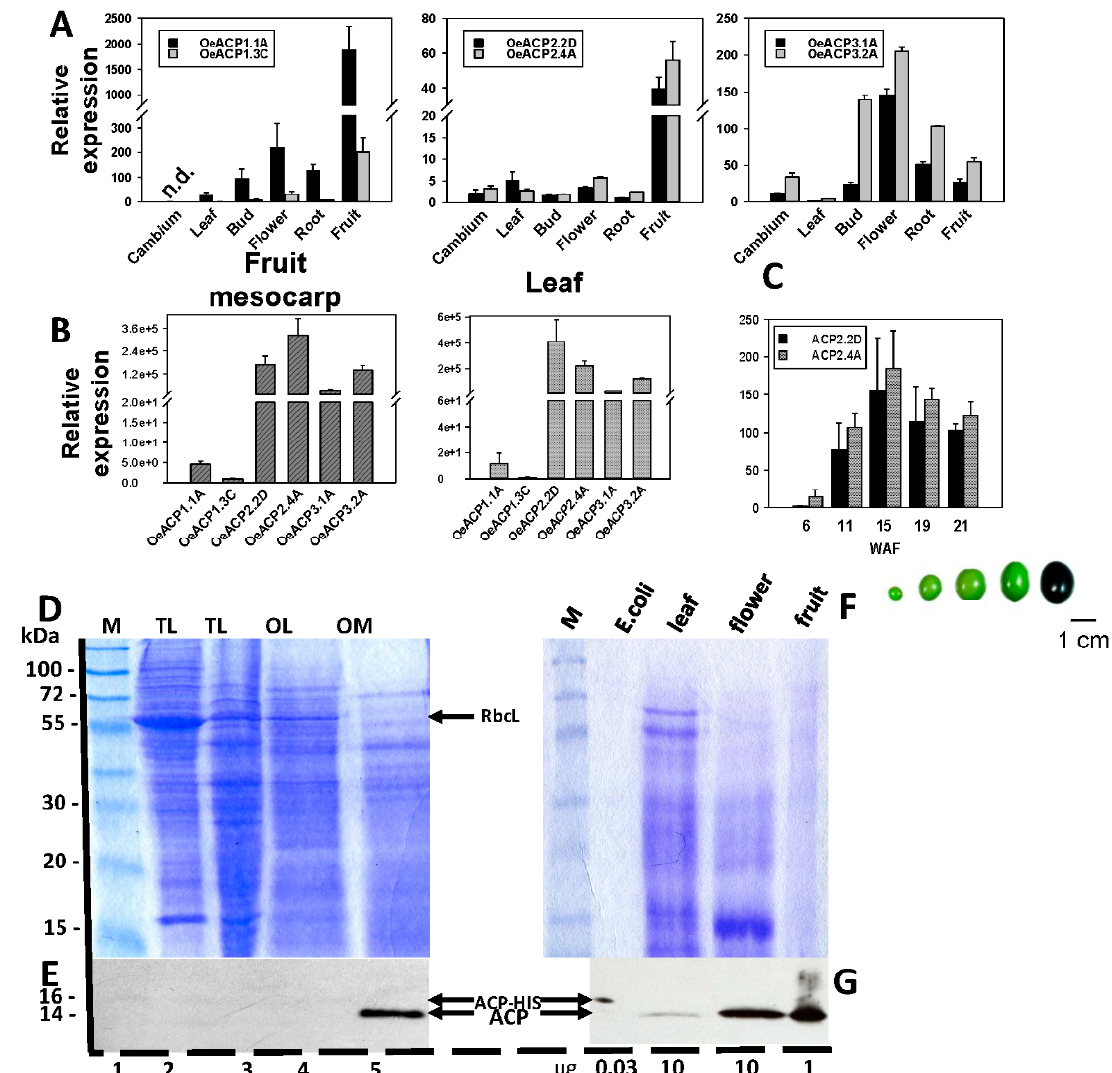
Figure 3. ( A ) Relative abundance of OeACP transcripts in different olive tissues, indicating signif- icant differences between alleles belonging to the same locus. ( B ) Relative abundance among all the ACP transcripts (compared in mesocarp and leaf). ( C ) Relative transcript abundance of locus OeACP2, alleles 2D and 4A in the mesocarp during fruit development, with statistical significance. ( D ) Separation of olive proteins by SDS-PAGE and specificity of the antiACP antibody: proteins extracted from tobacco leaf (TL), olive leaf (OL) and olive mesocarp (OM), with molecular mass markers (M). ( E ) Western blot analysis using anti-ACP antiserum on 10 µ g of leaf protein from several plant species. Separation by SDS-PAGE in two identical gels: ( F ) abundance of the ACP protein in different olive tissues with Western blot analysis using anti-ACP antiserum (the amount of proteins loaded in each lane, in µ g, is indicated under the figure); ( G ) stained gel with 0.1% Coomassie brilliant blue. Affinity-purified His-tagged ACP from Escherichia coli was used as a positive control. Numbers on the left indicate the positions of molecular mass markers in